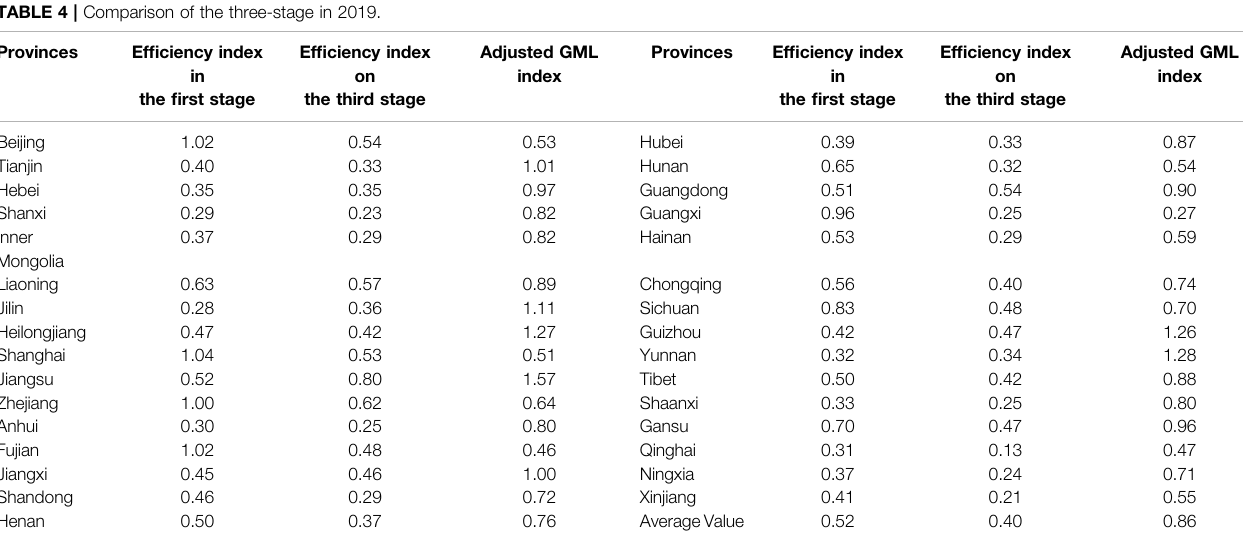
TABLE 4 | Comparison of the three-stage in 2019.